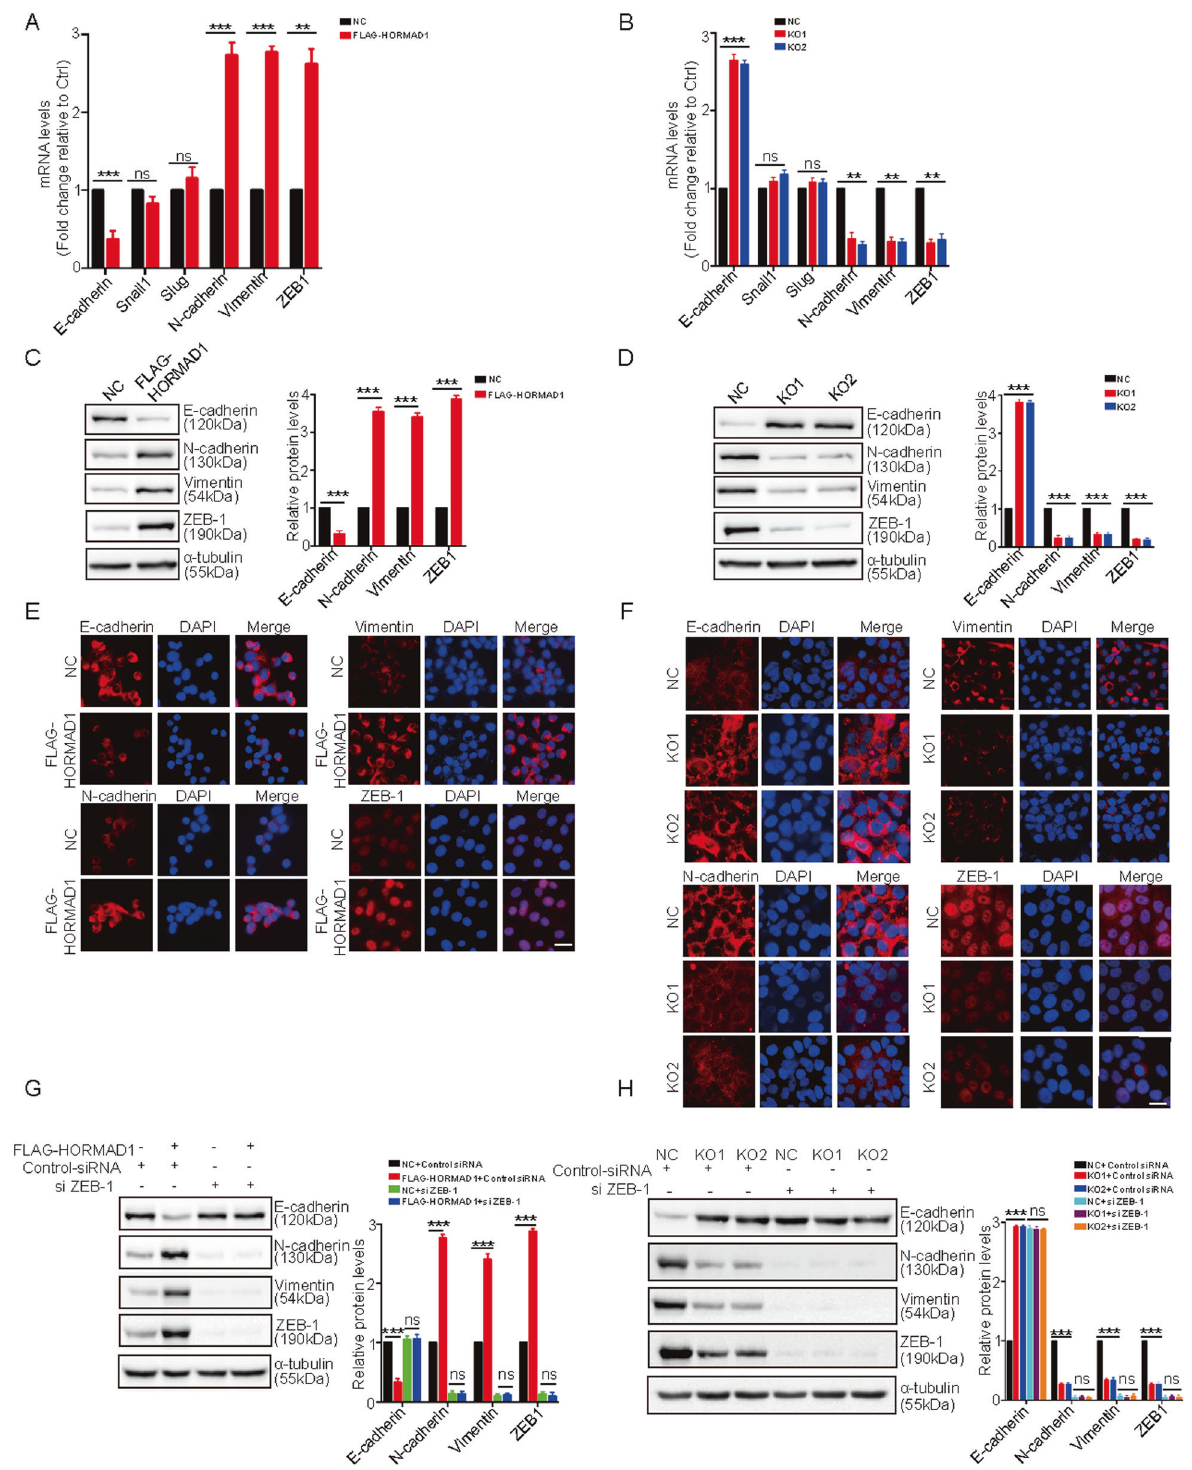
Fig. 4 HORMAD1 promotes epithelial – mesenchymal transition (EMT) in lung cancer cells. The relative mRNA levels of E-cadherin, Snail1, Slug, N-cadherin, Vimentin, and ZEB-1 in H157 cells with or without HORMAD1 expression ( A ) and in NC and HORMAD1 KO H650 cells ( B ) were determined by quantitative real-time PCR. The protein levels of E-cadherin, N-cadherin, Vimentin, and ZEB-1 in H157 cells with or without HORMAD1 expression ( C ) and in NC and HORMAD1 KO H650 cells ( D ) were analyzed by western blotting. Immuno fl uorescence staining analyses of E-cadherin, N-cadherin, Vimentin, and ZEB-1 in H157 cells with or without HORMAD1 expression ( E ) and in NC and HORMAD1 KO H650 cells ( F ); scale bars are 100 μ m. The protein levels of E-cadherin, N-cadherin, Vimentin, and ZEB-1 in H157 cells with or without HORMAD1 expression ( G ) and in NC and HORMAD1 KO H650 cells ( H ) were analyzed by western blotting after transfection with ZEB-1 siRNA. All histograms representing indicated the results of three independent experiments. Mean ± SEM from three independent experiments are shown. ** p < 0.01; *** p < 0.001; ns, not signi fi cant.